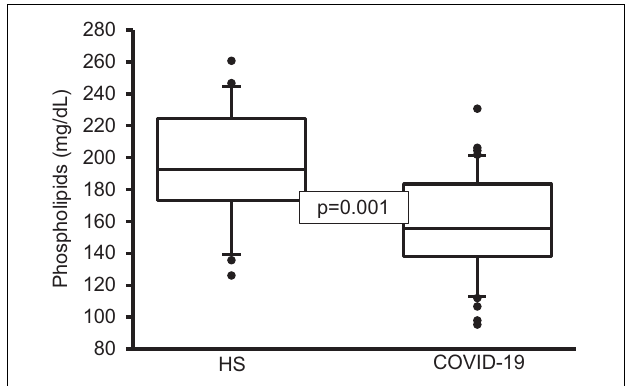
FIGURE 1 | Total phospholipids in plasma of HS and COVID-19 patients. The main phospholipids are phosphatidylserine, phosphatidylcholine, phosphatidylethanolamine, sphingomyelin, and phosphatidylinositol. A decrease significant is observed in COVID-19 patients vs. HS. Statistical significance was determined by the Mann–Whitney rank sum test followed by the normality test (Shapiro-Wilk). Values expressed represent the median and Min–Max range ( n = 42 COVID-19 patients and 22 HS). COVID-19 = coronavirus disease-19, HS = healthy subjects.